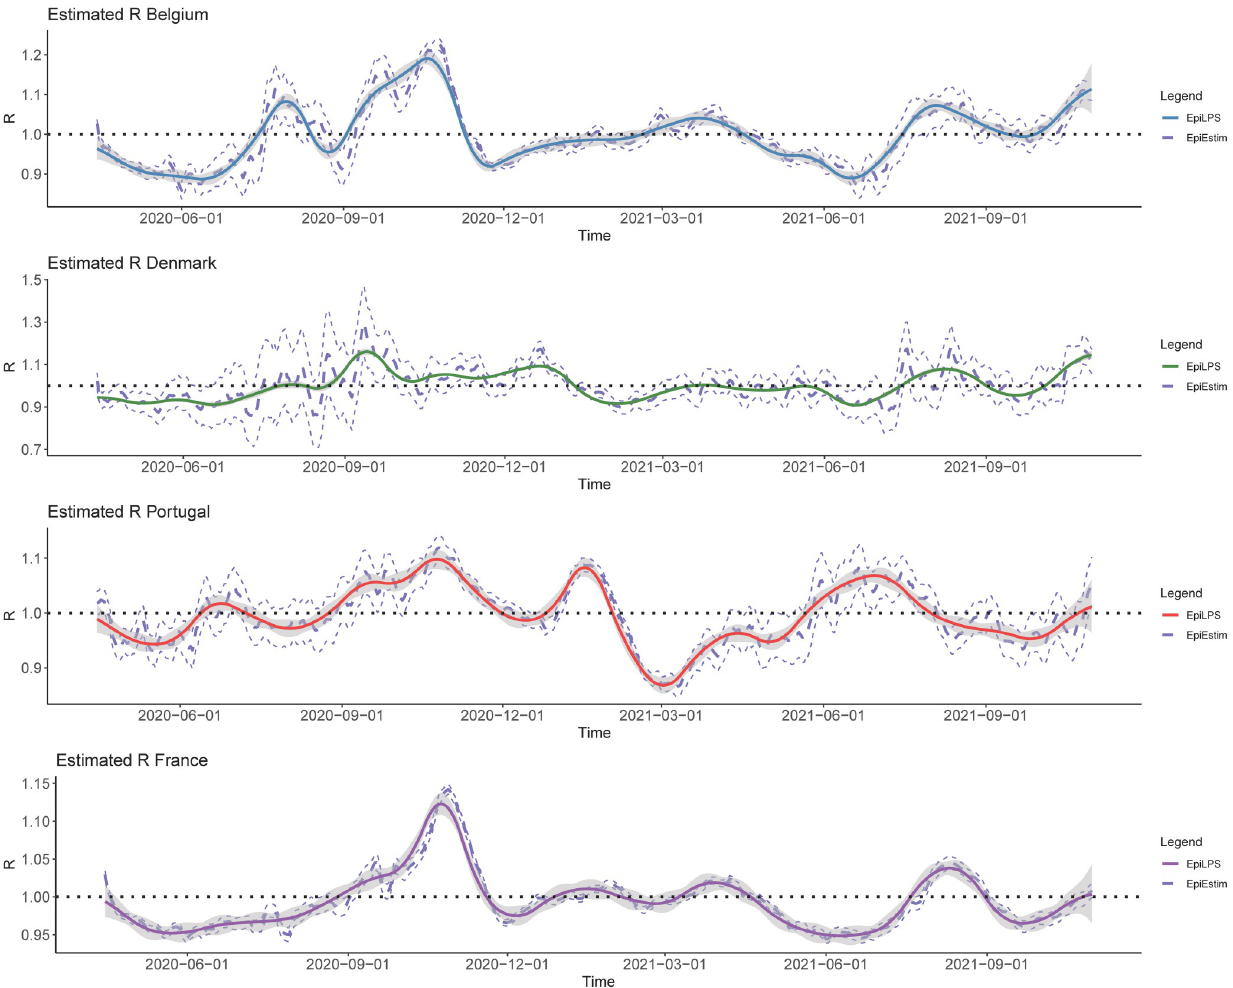
Fig 10. Estimated reproduction number from 2020–04-05 to 2021–10-31 for Belgium, Denmark, Portugal and France with LPSMAP using K = 30 B- splines and a second-order penalty. The shaded area corresponds to the 95% credible interval at each day. Dashed curves are results obtained with EpiEstim (with weekly sliding windows and estimated R reported at the end of the t